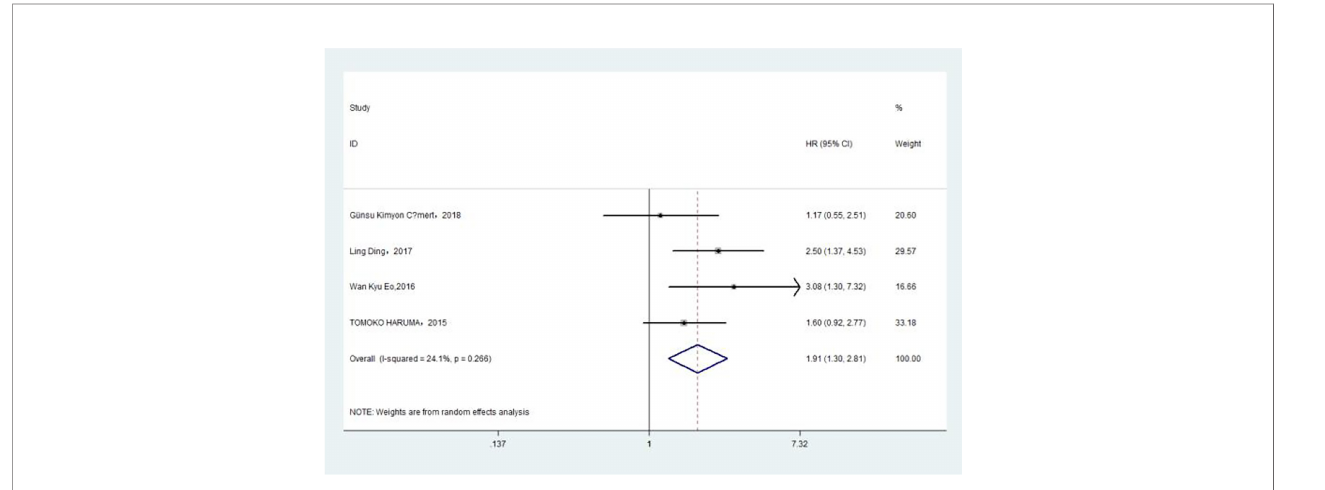
FIGURE 6 | Relationship between platelet – lymphocyte ratio and disease-free survival in univariate